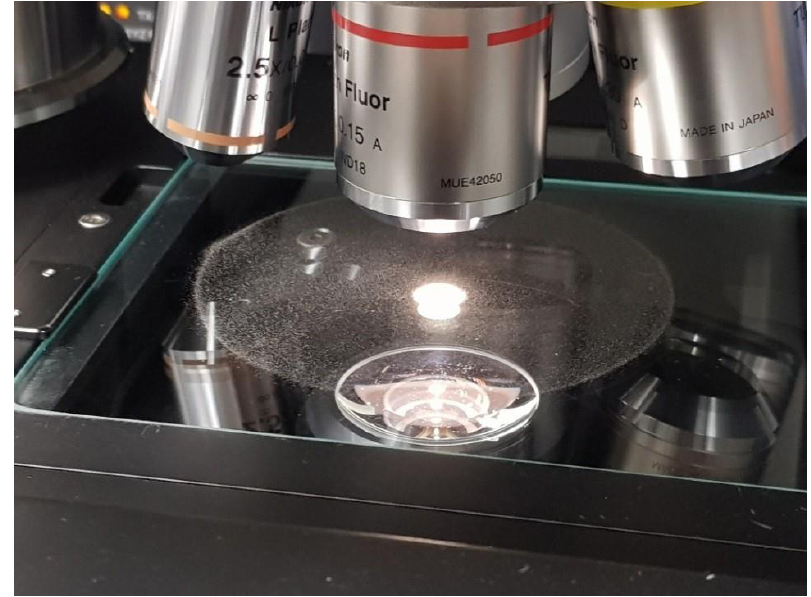
Figure 2. Image of dispersed powder test method for analysis of particle shape.